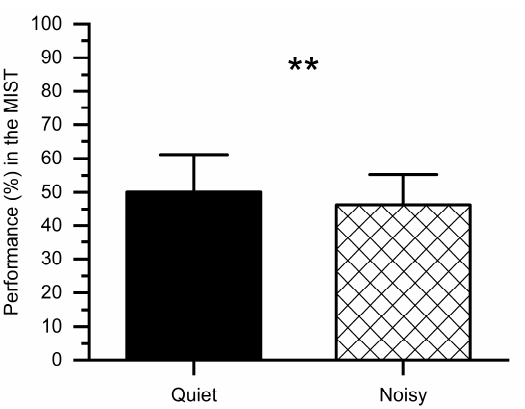
Figure 4. Percent performance in the MIST under stress conditions at quiet and noisy workplaces. Error bars indicate the standard deviations and stars (**) indicate significant differences ** p < 0.01.